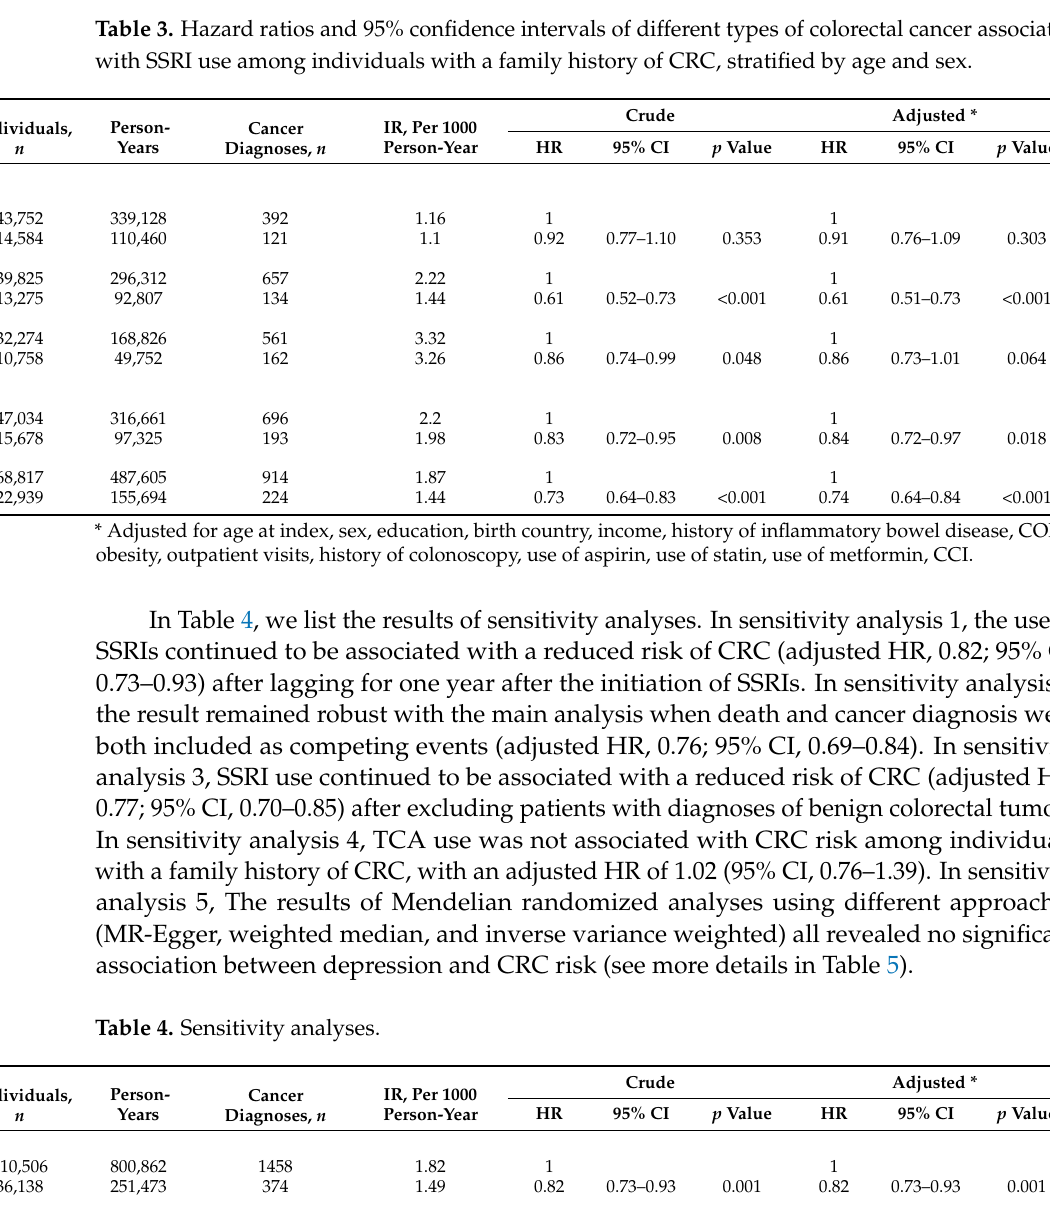
Table 4. Sensitivity analyses.